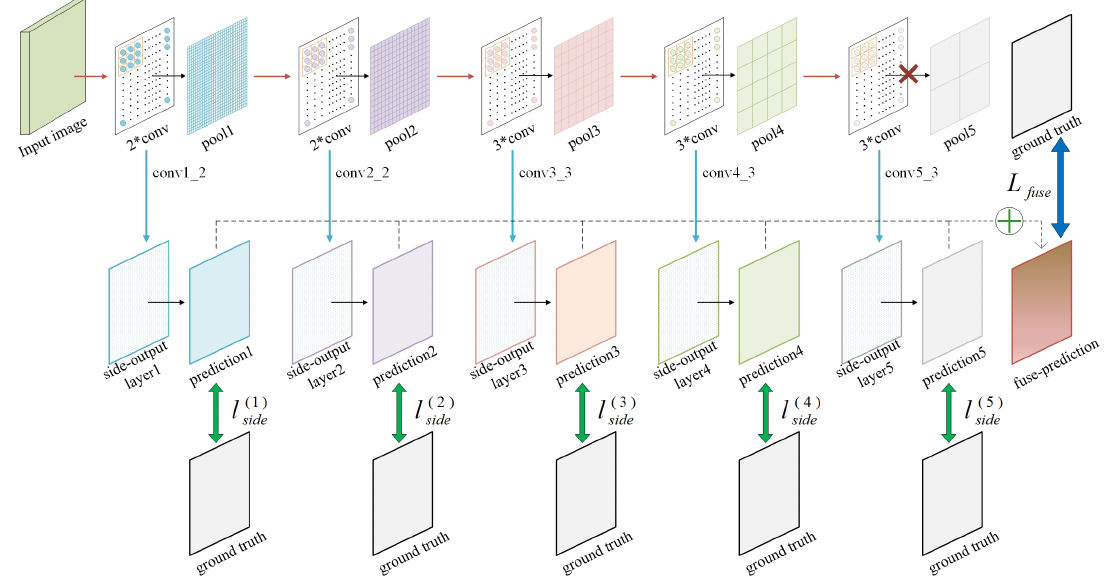
Figure 4. Architecture of HED network. The side-output layer here is composed a convolution layer with kernel size of 1 × 1 and a deconvolution layer for upsampling. All loss functions are fused. Calculation details of HED are as